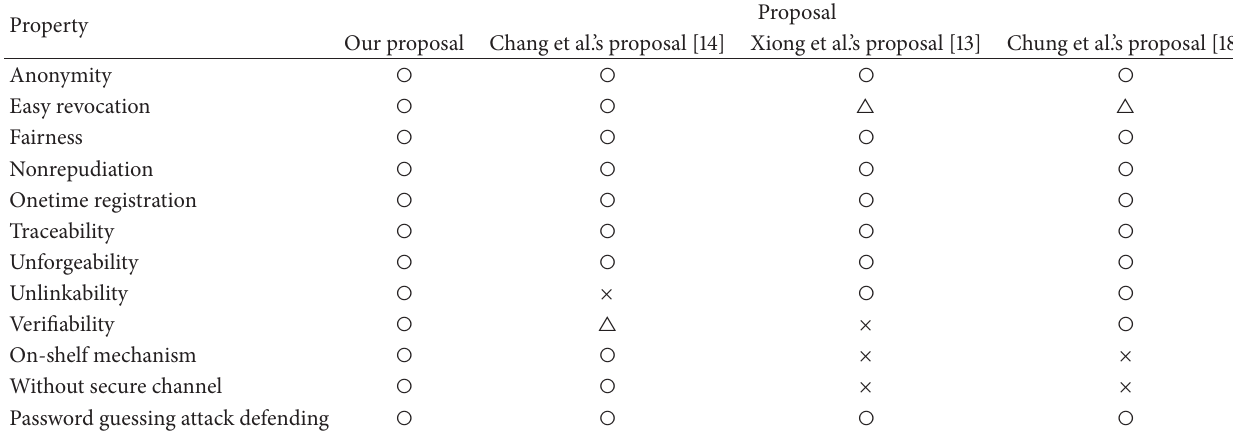
Table 1: Comparison in security properties of the three schemes.